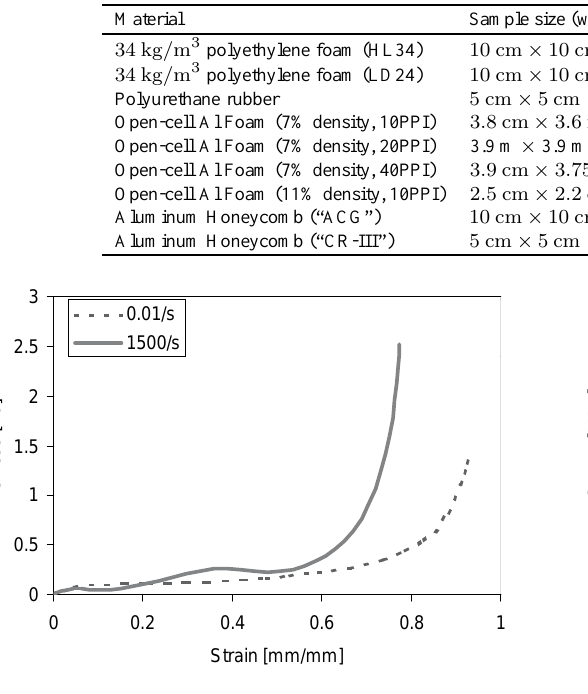
Fig. 2. Stress-strain behaviour of HL34 foam. Fig. 3. Stress-strain behaviour of LD24